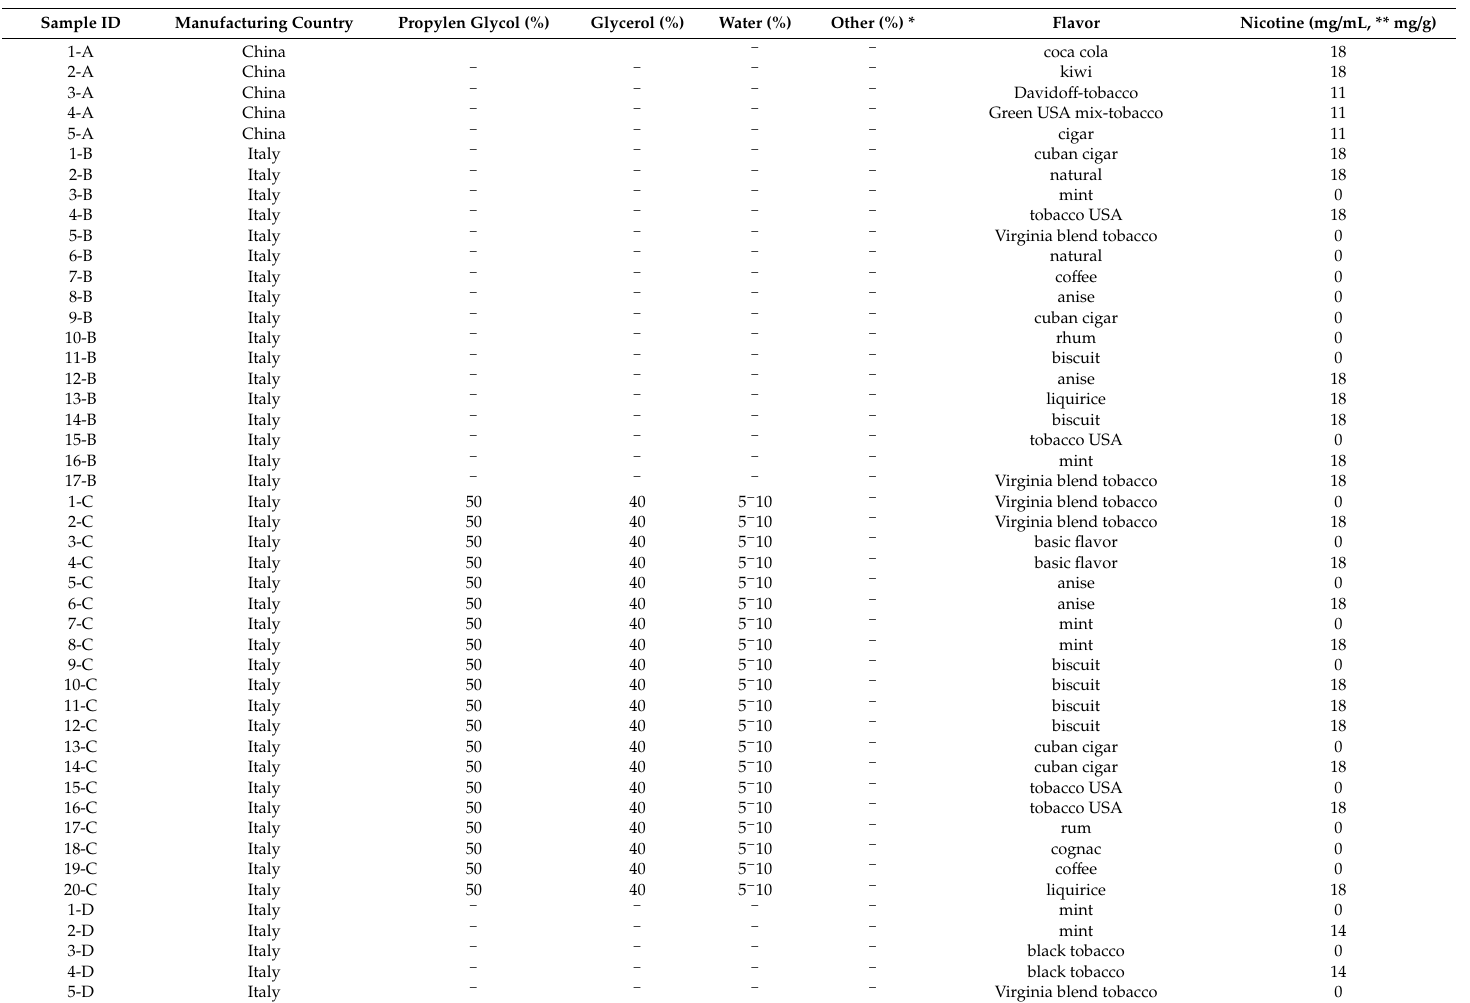
Table 1. E-liquids composition and information: manufacturing country, % of the main components, characteristic flavor and nicotine content (expressed as mg / mL or mg /